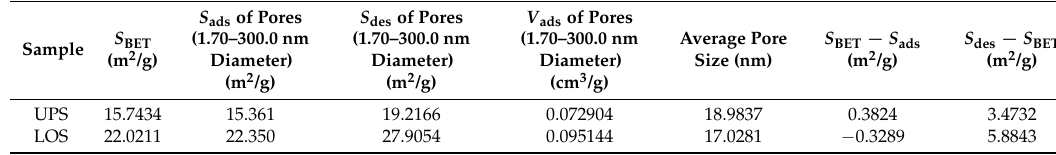
Table 1. Surface area and pore size data of the UPS and LOS samples.